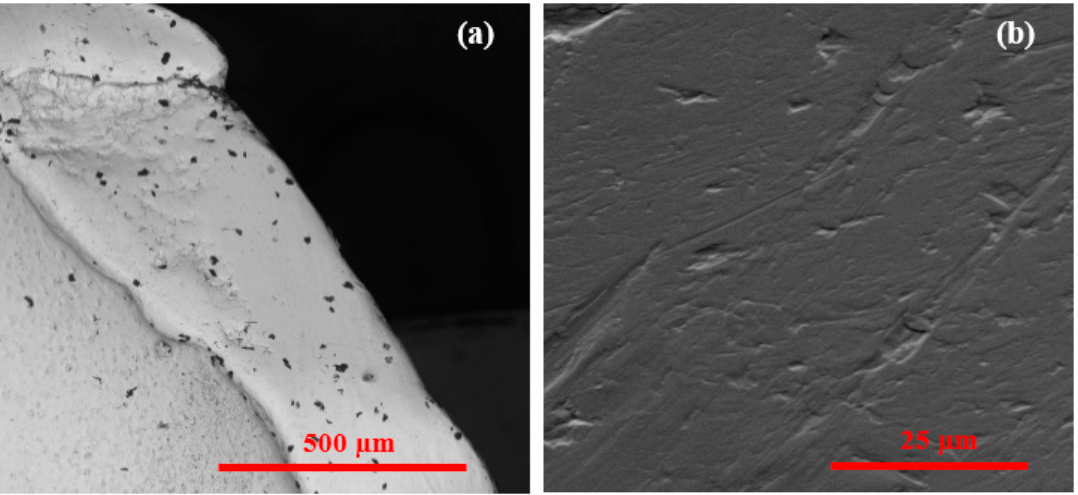
Figure 5. Backscattered electron images of likely inclusions ( a ) SEM EBSD image of area 2 ( b ) Topographical SEM image of area 3.